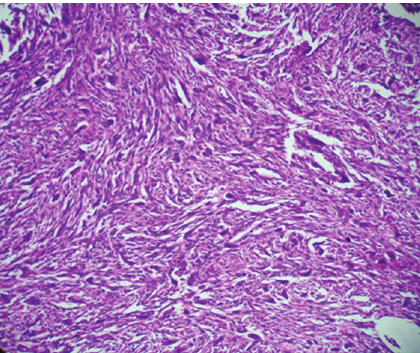
Figure 3: Focal chondrosarcomatous area amidst undi ff erentiated carcinoma (H&E, 400x).